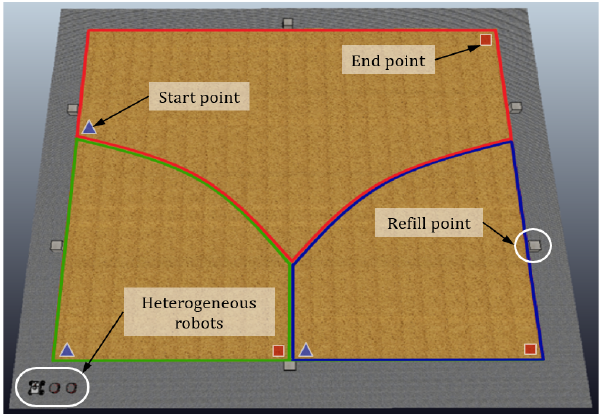
Figure 6. Simulator environments for heterogeneous seeding robots.